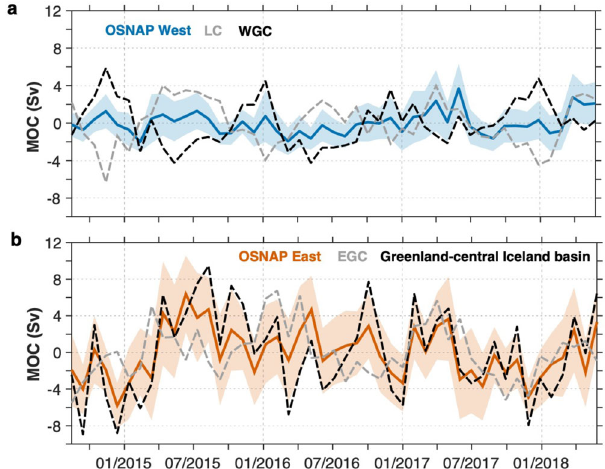
Fig. 4 Components of overturning variability. a OSNAP West Meridional Overturning Circulation (MOC) anomalies: overturning derived from the Labrador Sea array (blue; shading indicates uncertainty as shown in Fig. 2); MOC variability arising from time-varying density and velocity anomalies in the Labrador Current (LC; light gray) computed with time-mean velocities/ densities at the West Greenland Current (WGC) boundary, and MOC variability arising from density and velocity anomalies in the WGC (black) computed with time-mean velocities/densities at the LC boundary. b OSNAP East MOC anomalies: overturning derived from the OSNAP East array (red; shading indicates uncertainty as shown in Fig. 2); MOC variability arising from time-varying density and velocity in the region between Greenland and mid-Iceland basin (black) computed with time- mean velocities/densities at the eastern boundary, and MOC variability arising from density and velocity anomalies in the East Greenland Current (EGC; light gray) computed with time-mean velocities/densities everywhere else. For the reconstruction based on the time-varying data at the western boundary (light gray line), the MOC is de fi ned as the minimum of the stream function integrated from the bottom to the sea surface in density space (sign has been changed for